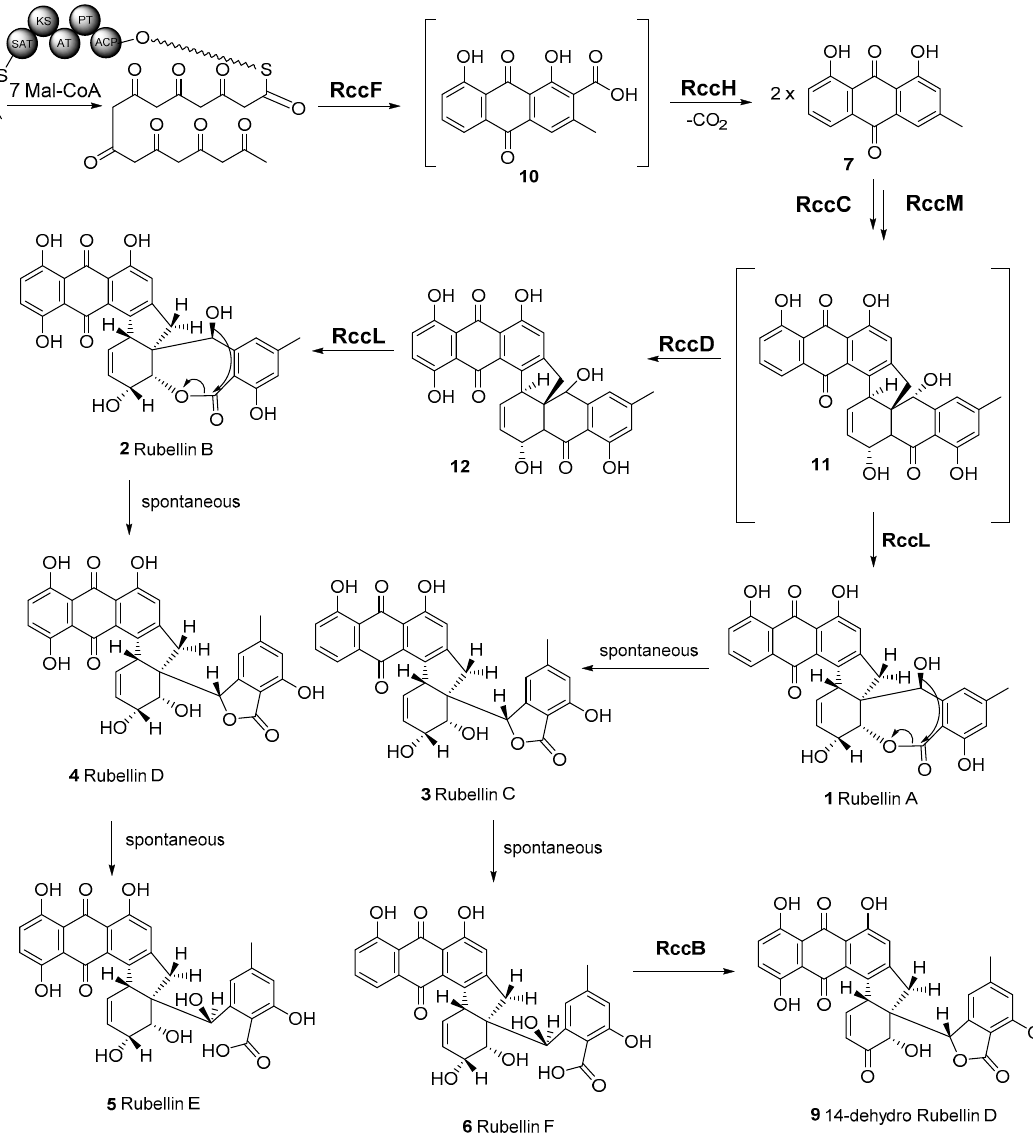
Figure 6. Proposed biosynthetic pathway of rubellins A–F ( 1 – 6 ) and 14-dehydro rubellin D 9